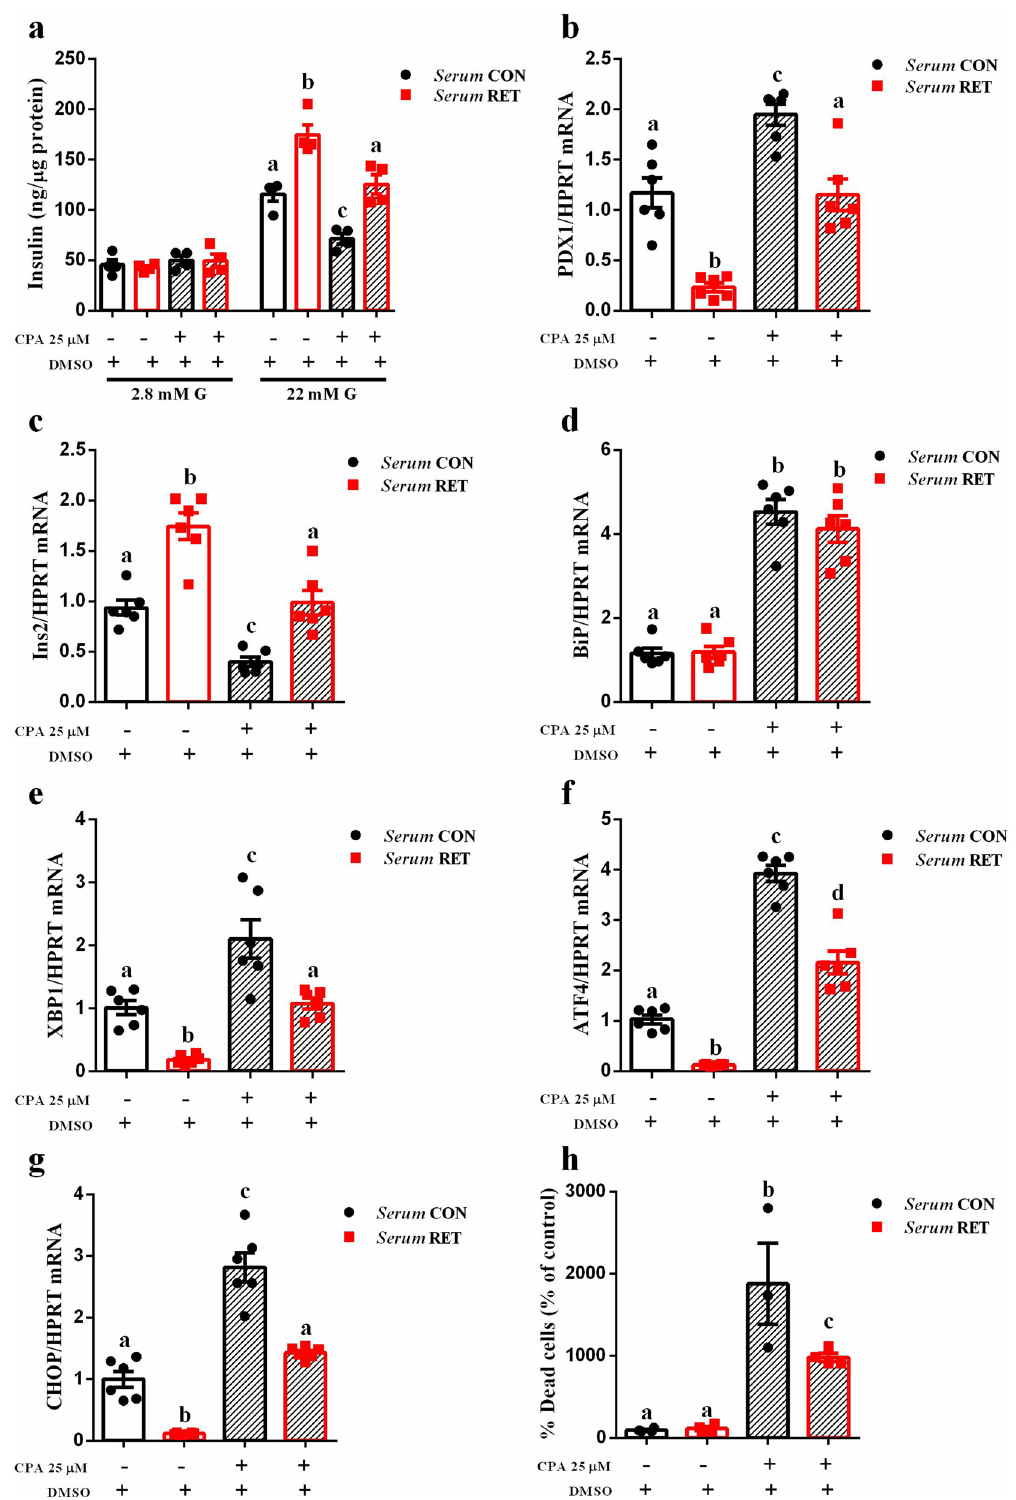
Figure 4. Serum from resistance-trained mice protects INS-1E cells from ER stress injury and apoptosis. INS-1E cells were incubated with conditioned medium with 10% of serum from control (striped black bar) or trained mice (striped red bar) for 24 h, followed by 16 h exposure to 25 µM CPA. Insulin secretion from INS1-E cells exposed to 2.8 or 22.2 mM glucose (n = 4) ( a ), Real-time PCR assay of PDX1 ( b ), Ins2 ( c ), BiP ( d ), XBP1 ( e ), ATF4 ( f ) and CHOP ( g ) mRNA levels (n = 6) in INS-1E cells from different treatments as indicated in the graph. The relative expression of mRNAs was determined after normalization with HPRT. Cell apoptosis was measured by HO and PI staining (n = 3–4). The % of dead cells (HO/PI stained cells ratio) is represented as % of control (Serum CON cells without CPA) ( h ). Data are the mean ± SEM. Different letters indicate statistic differences between groups, P ≤ 0.05 (One-Way